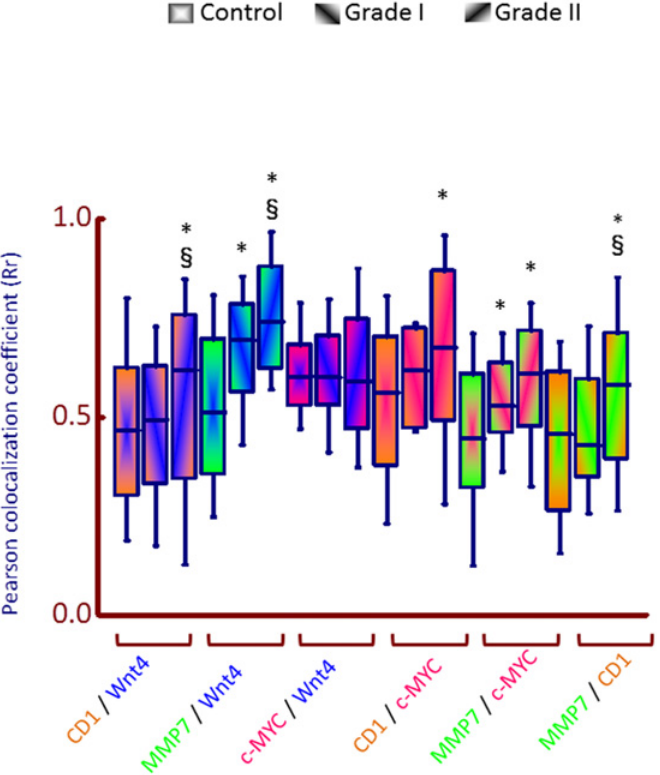
Fig 4. Box plot of differential pattern for WNT4, MMP7, CD1 and c-MYC co-expression in control and malignant penile tissue. Quantitative co-localization was performed from high magnification images (e.g. as represented in Fig 3) and image files used for quantitation as described in materials and methods in WCIF ImageJ software co-localization plugin to measure the Pearson coefficient of co-localization. 35 individual tissue cores that included control (gradient from centre ) and malignant grade I (gradient from left to right ) and grade II (gradient from right to left ) were used for each fluorophore to calculate the co- localization of expression of WNT4, MMP7, CD1 and c-MYC, generating 12 comparisons: CD1 and WNT4 (orange/blue), MMP7 and WNT4 (green/blue), c-MYC and WNT4 (pink/blue), CD1 and c-MYC (orange/pink), MMP7 and c-MYC (green/pink), MMP7 and CD1 (green/orange). Significance of difference in the Pearson coefficient of co-localization between control and grades I and II ( * 0.02 – 0.04) and between grade I and grade II (§ p < 0.04, range 0.04 – 0.0001) samples was calculated using the Mann-Whitney U test; boxes showing comparisons without symbols are not significantly